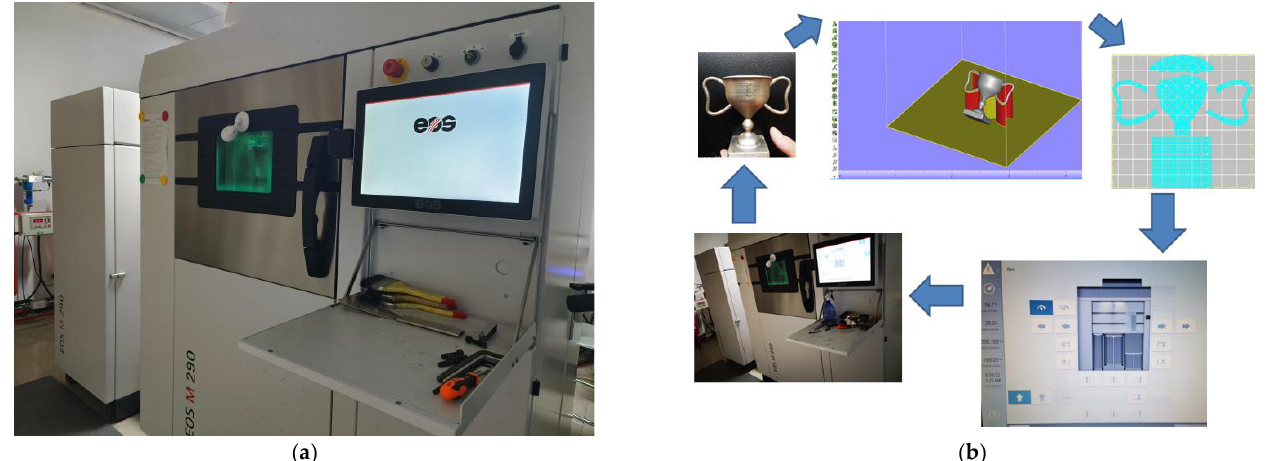
Figure 3. ( a ) Photograph of the EOS M290 LPBF system and ( b ) flow diagram showing the LPBF processes.